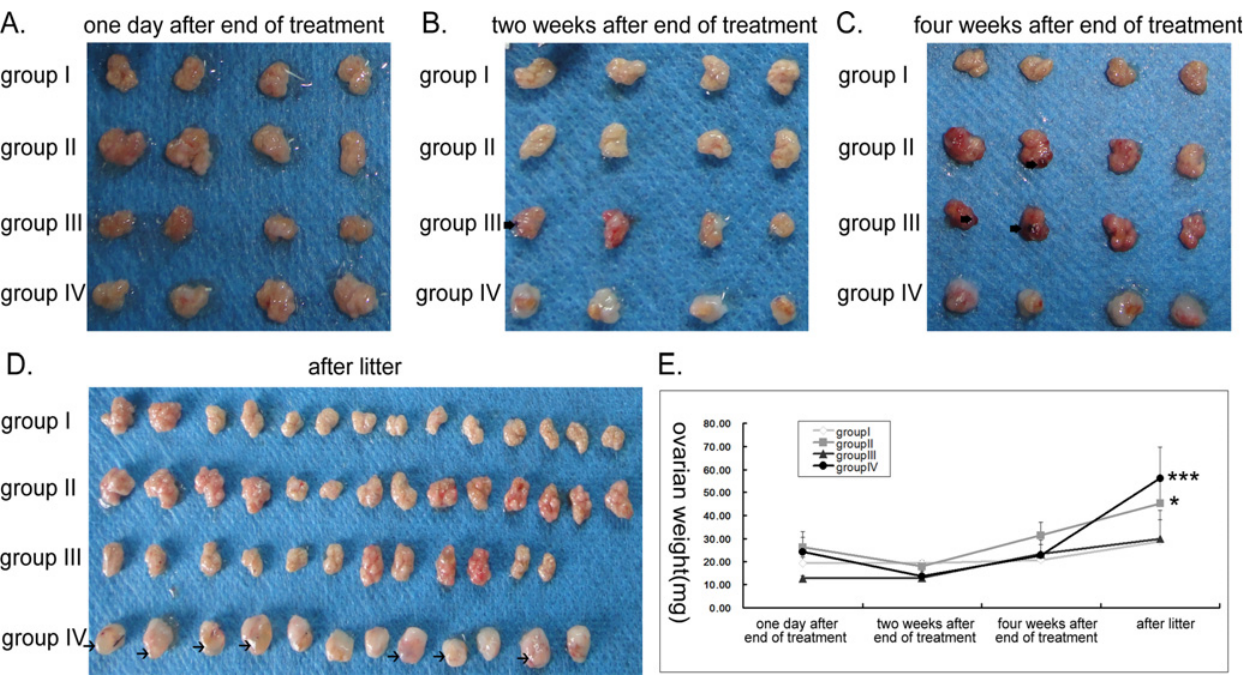
Fig 2. Ovarian morphology and weight at different time points following treatment cessation. Ovarian morphology were compared between different groups at: (A) one day after end of treatment (2 rats), (B) two weeks after end of treatment (2 rats), the black thick arrow points to the black blot on the ovarian surface (C) four weeks after end of treatment (2 rats), the black thick arrow points to the black blot on the ovarian surface (D) after litter, the thin arrow points to the transparent follicles on the ovarian surface (7 rats in group I and group II, 6 rats in group III and group IV). (E) Ovarian weight at different time points. * p < 0.05, *** p <